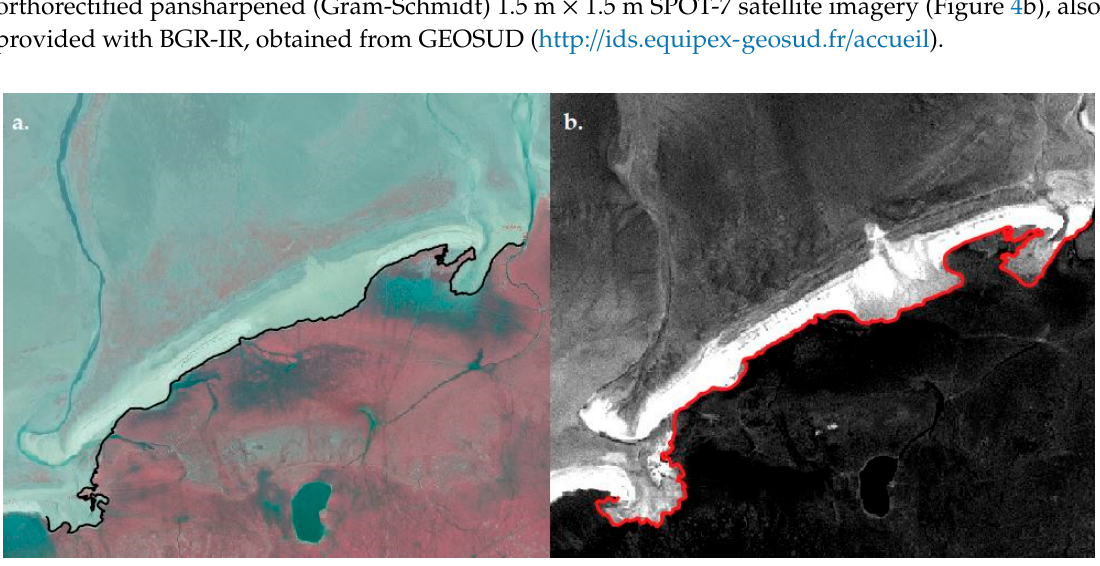
Figure 4. Optical imagery data sources over Sainte-Anne site: ( a ) Ortholittorale Version 2 aerial and ( b ) SPOT-7 satellite imageries.